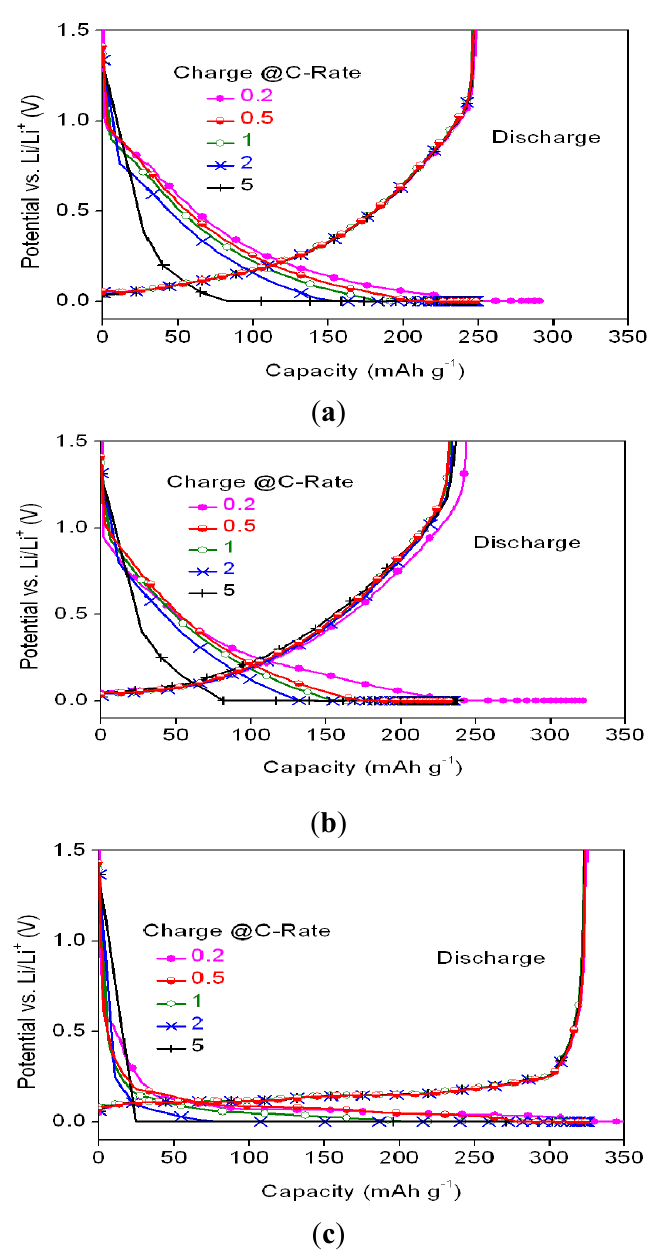
Figure 7. Potential profiles of the cell with ( a ) MSC, ( b ) HC, and ( c ) SMG anode materials at various charge C-rates and 0.2 C discharge